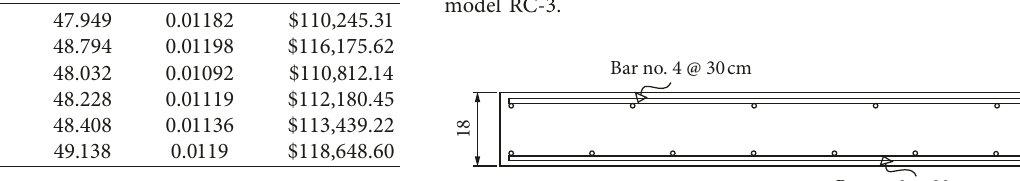
1 and F 2 for the best individuals of